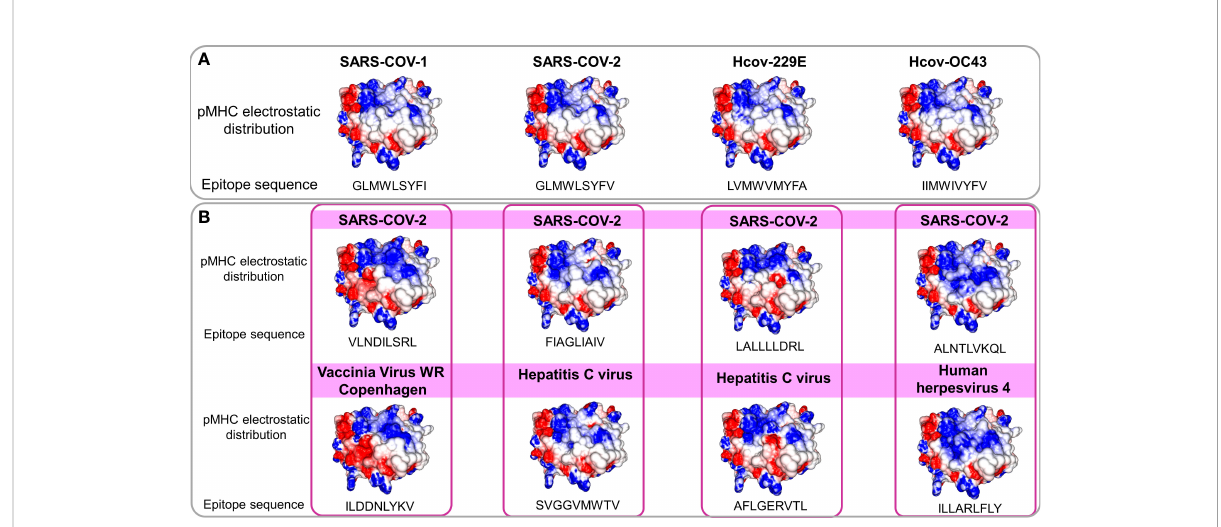
FIGURE 3 Comparison of electrostatic surface distribution and topography of SARS-CoV peptides with alphacoronaviruses and other prevalent viruses in human populations. pMHCs models compared in terms of topography and electrostatic distribution. In (A) , two beta (SARS-CoV-1 and 2) and two alpha and beta (229E and OC43), coronaviruses show shared electrostatic distribution and topography despite their sequence divergences. In (B) , a panel of four SARS-CoV peptides (top) compared with pMHCs containing viral epitopes from members of other viral families (bottom). Disregarding the lack of sequence identity and phylogenetic relationship, models present structural similarities. Electrostatic calculations are depicted as negative (red) and positive (blue)